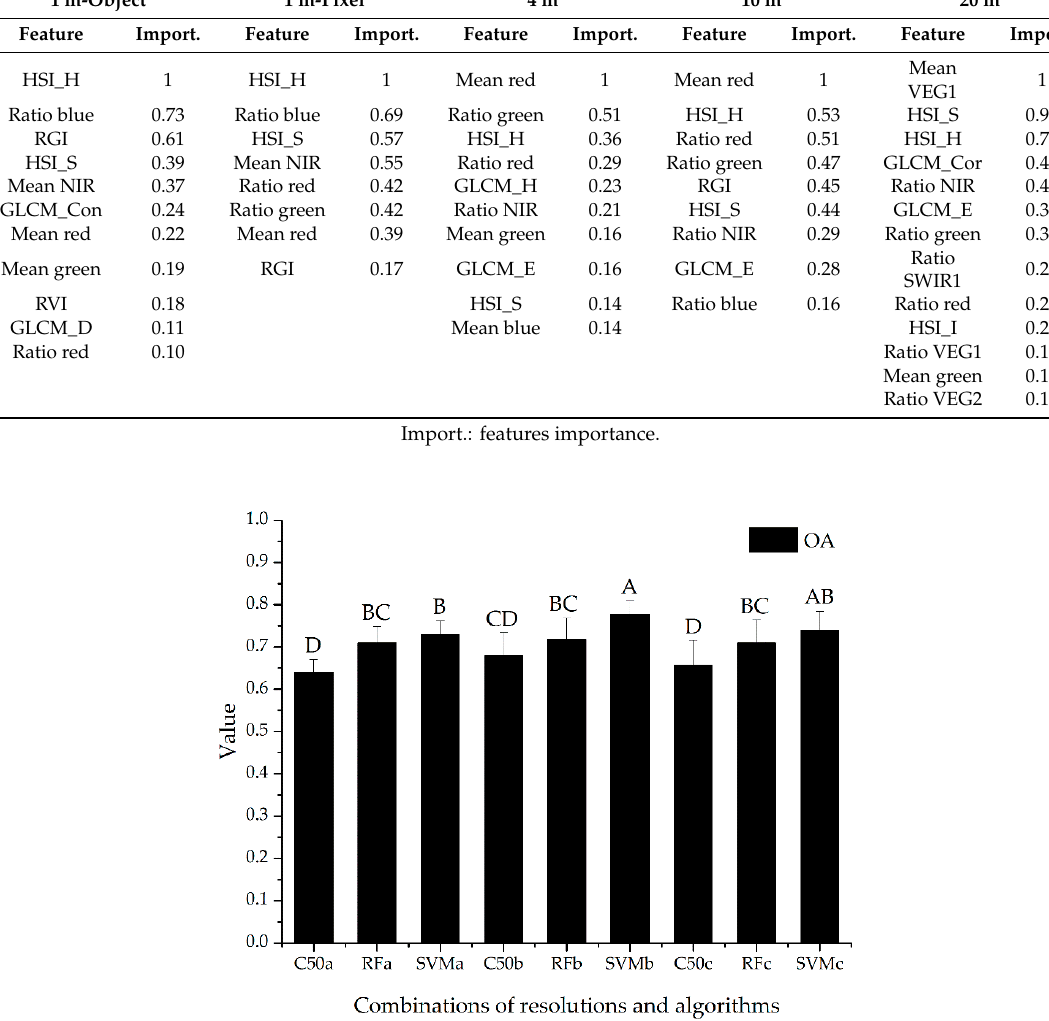
Figure 5. Detail example of the image classification of study areas. ( a ) 1m resolution image based on the pixel method and SVM algorithm; ( b ) 1m resolution image based on the pixel method and RF algorithm; ( c ) 1m resolution image based on the pixel method and C50 algorithm; ( d ) 1m resolution image based on the object method and SVM algorithm; ( e ) 4m resolution image based on the SVM algorithm; ( f ) GF2 true color image; ( g ) UAV image.